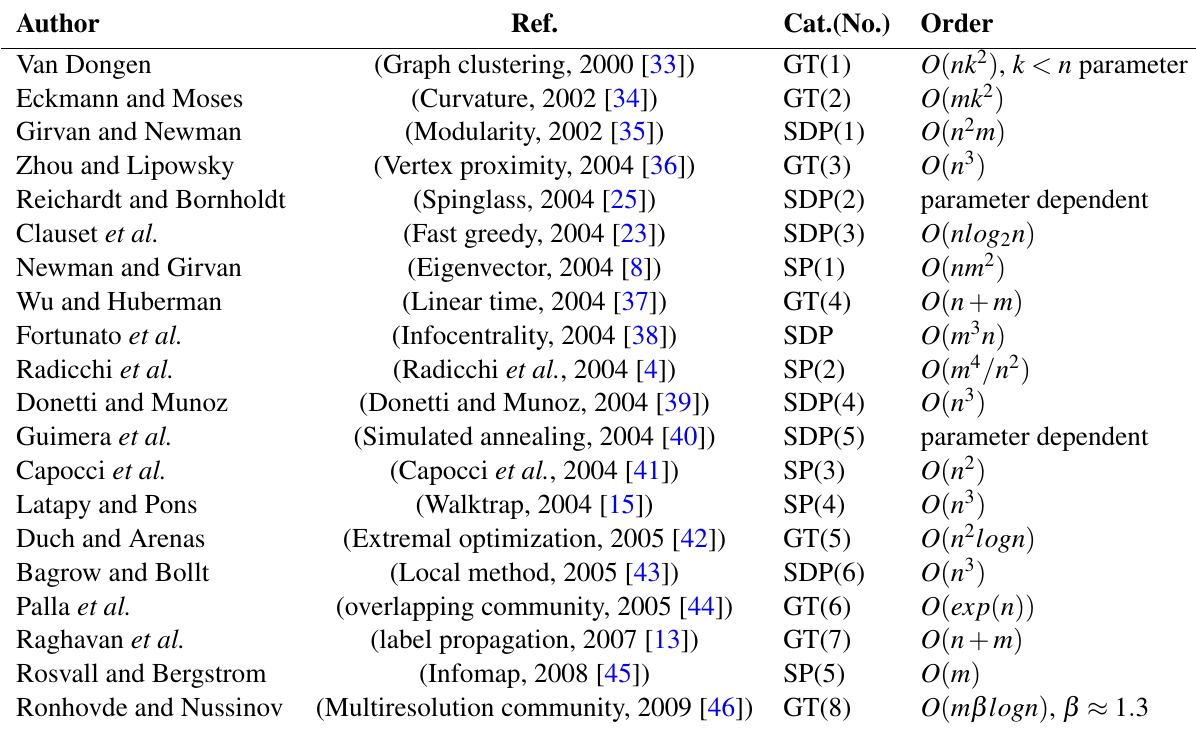
Table 1. Algorithms for network community detection and their complexities. GT, graph traversal; SDP, semi-definite programming; SP,